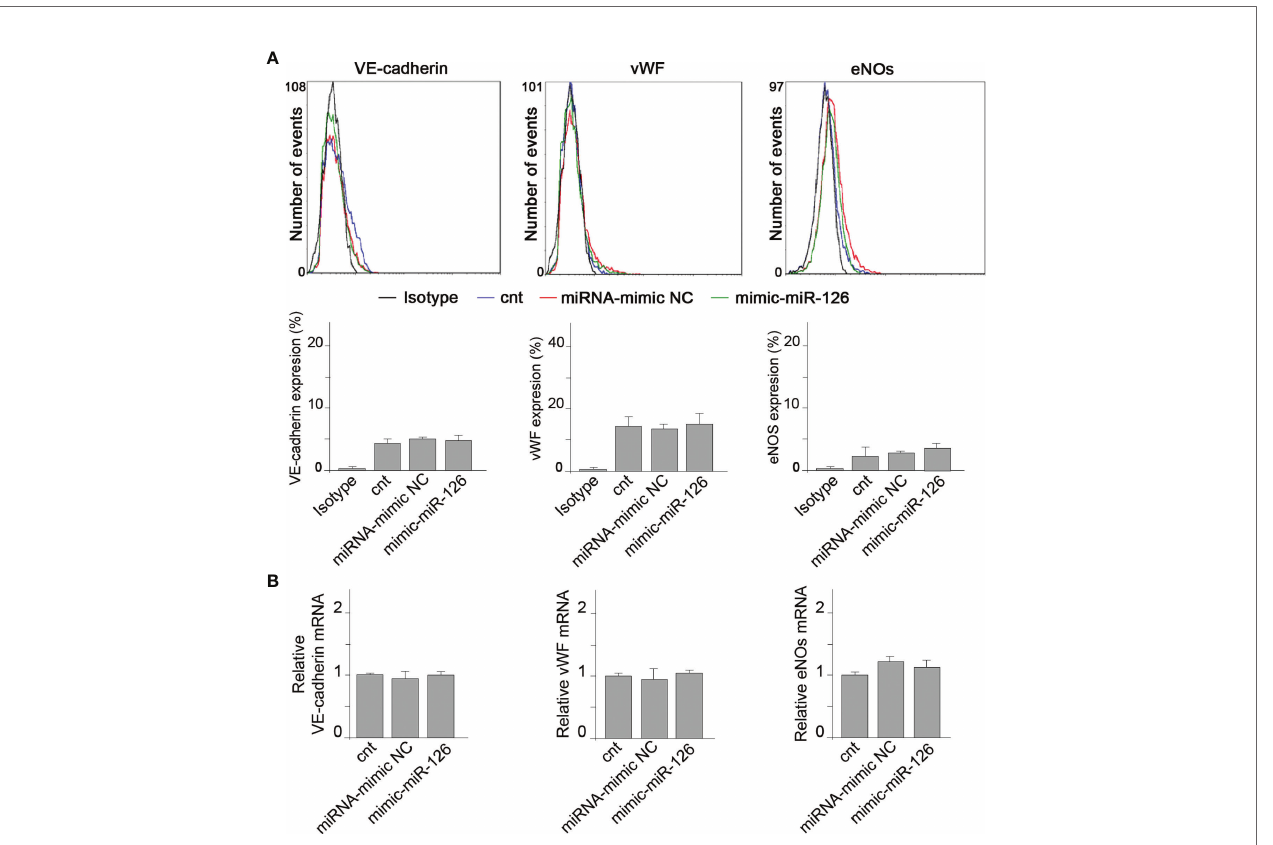
FIGURE 4 | MiR-126 in RMCs does not induce vascular endothelial cell marker expression. (A) Expression of VE-cadherin, von Willebrand factor (VWF), and eNOS was analyzed by fl uorescence-activated cell sorting (FACS) analysis in RMCs not transfected (cnt) or transfected with miRNA mimic-negative control (NC) or mimic- miR-126. Unspeci fi c IgG antibody was used as a control. Histograms show analysis from 6 experiments. Values are expressed as mean ± SEM. Statistical analysis was performed by ANOVA followed by Tukey ’ s post-hoc test. (B) mRNA expression of VE-cadherin, von Willebrand factor (VWF), and eNOS was analyzed by qRT- PCR in RMCs not transfected (cnt) or transfected with miRNA mimic-negative control (NC) or mimic-miR-126. Values are expressed as mean ± SEM. Statistical analysis was performed by ANOVA followed by Tukey ’ s post-hoc test ( N =